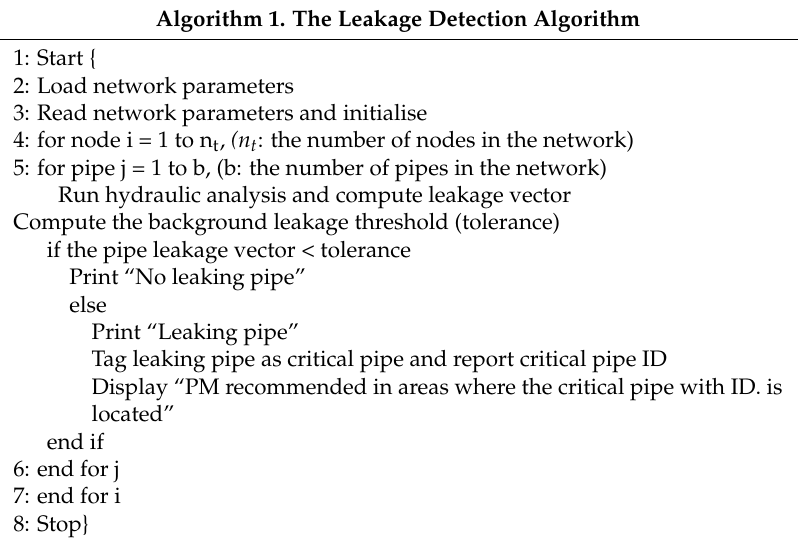
Table 1. Proposed leakage detection algorithm. Algorithm 1. The Leakage Detection